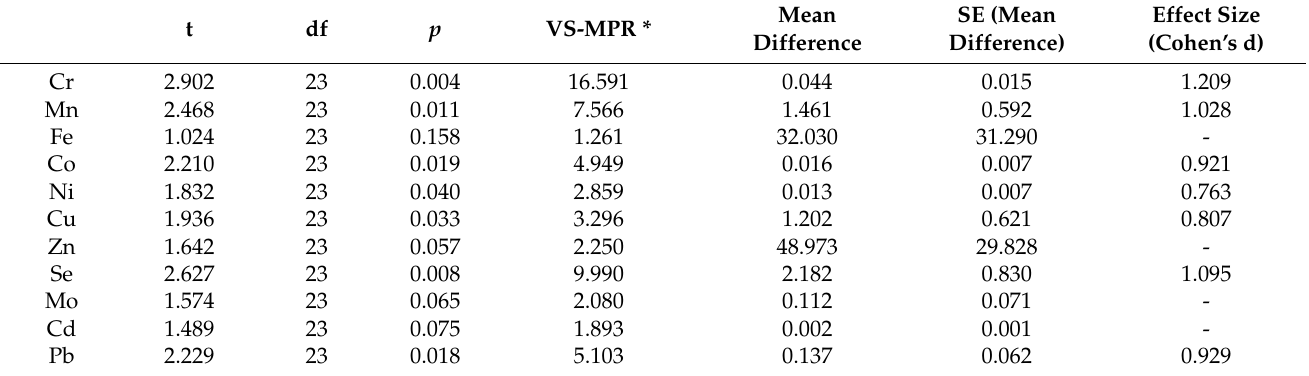
Table 3. Independent Samples t -test of the trace elements in Sulguni and Imeruli cheese.